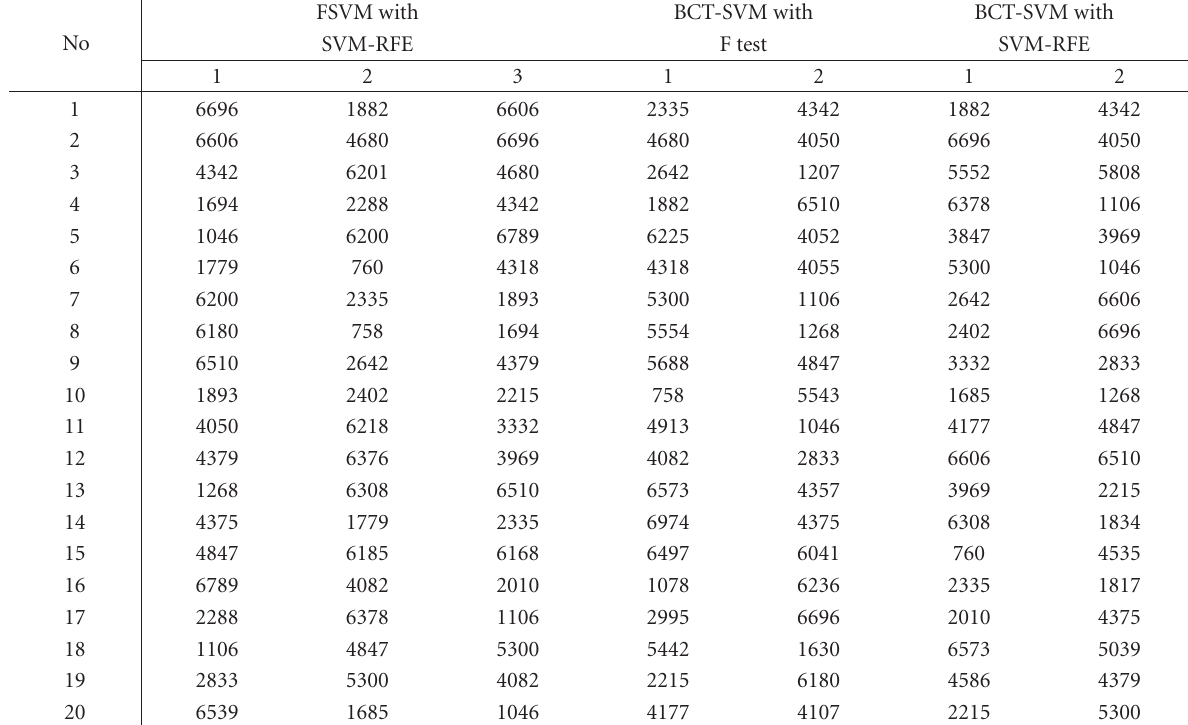
Table 7. The index no of the strongest genes selected in acute leukemia dataset.